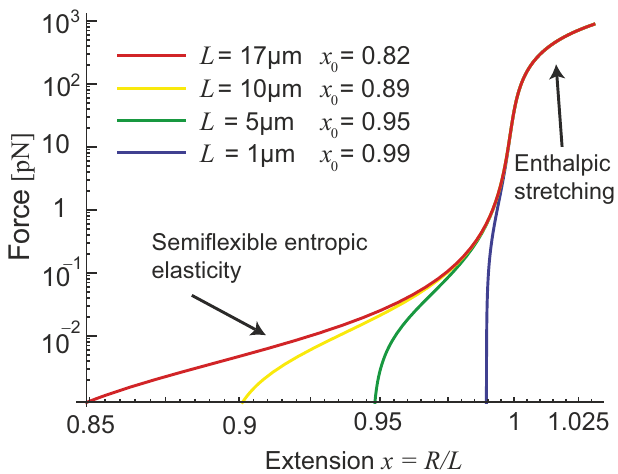
Figure 4. The comparison of the entropic (bending) and the tensile elasticity effects in the effective stretching modulus of a filament. Logarithmic force-extension curves show the response of extensible filaments using Equation (16). Parameters correspond to those of an actin filament of the persistence length l p = 17 µ m, Young modulus Y = 2 GPa, filament diameter 7nm, and several values of natural length L labelled in the plot. The crossover regime starts at f c , when the ‘linear-entropic’ response becomes ‘nonlinear-entropic’ (as in Figure 3). The width of this crossover regime is determined by the ratio of k m / k e (see text), after which the ‘linear-mechanical’ (enthalpic) regime dominates, with the elastic modulus k m .